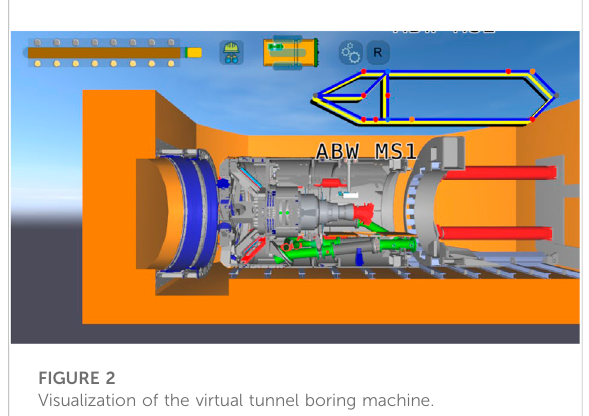
FIGURE 2 Visualization of the virtual tunnel boring